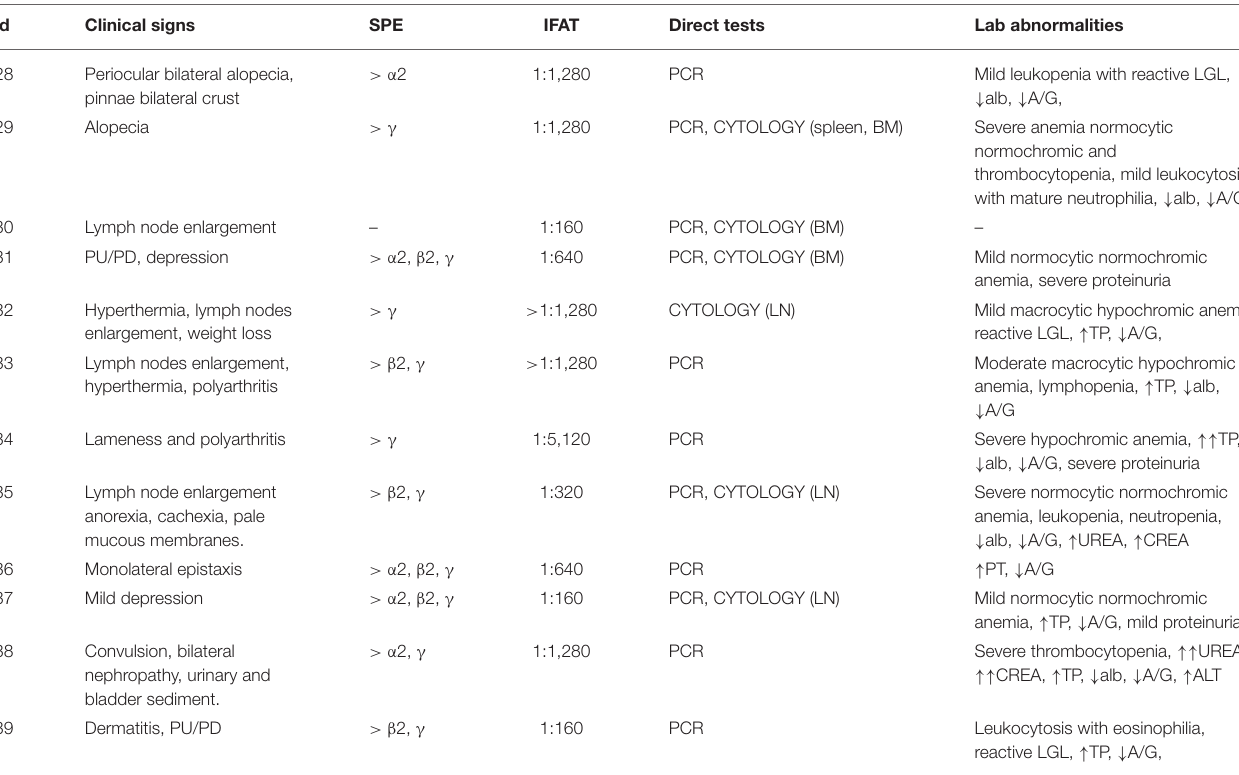
TABLE 3 | Clinical signs and laboratory abnormalities of the dogs belonging to S